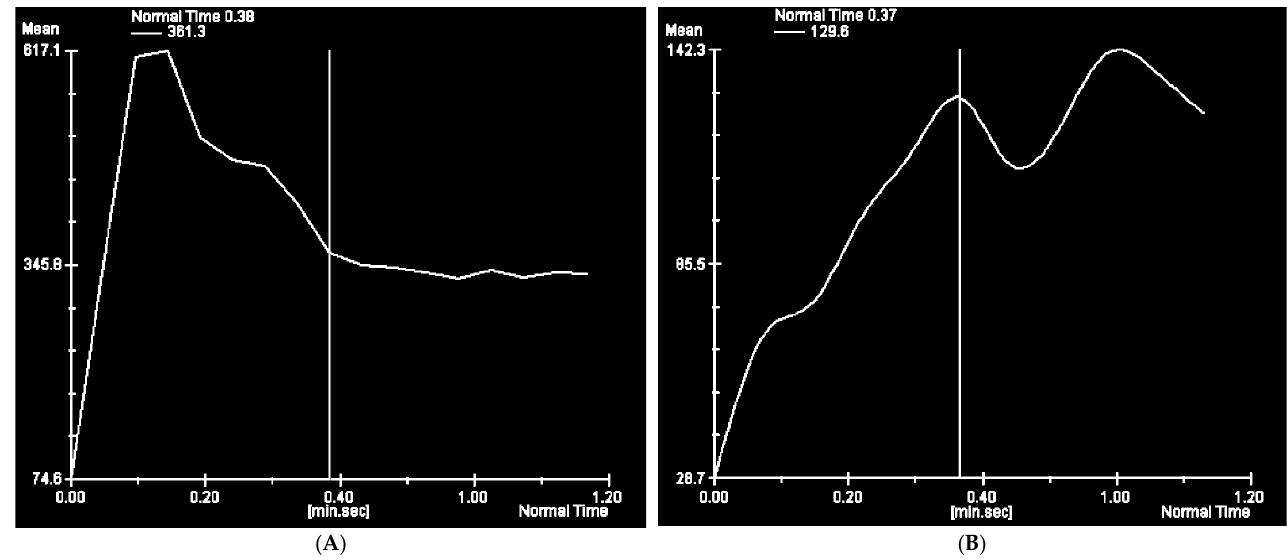
Figure 3. Time intensity curves for: ( A ) high-flow vascular malformations (HFVMs); ( B ) low-flow vascular malformations (LFVMs).